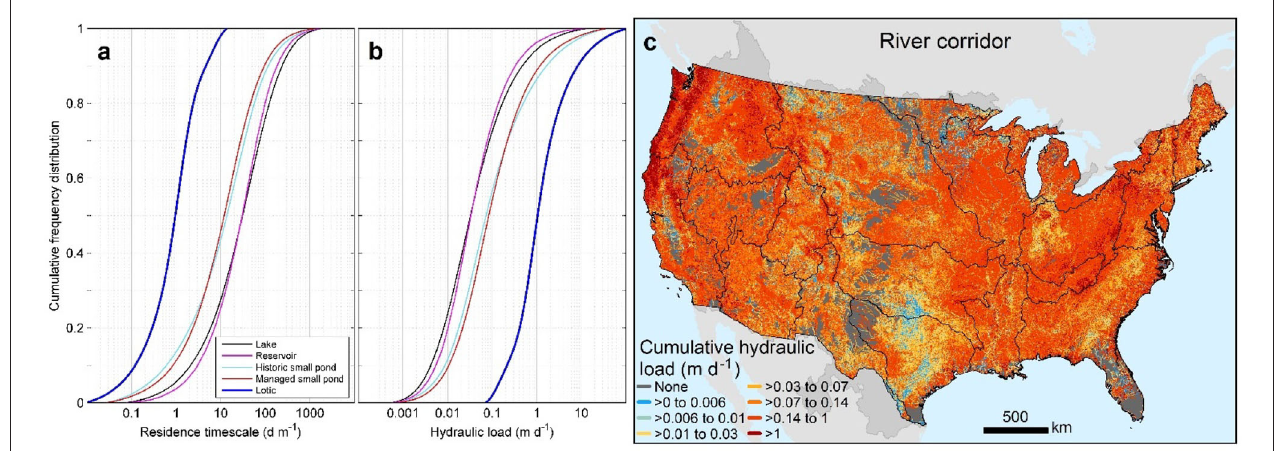
FIGURE 4 | Frequency distributions of residence timescale (a) and hydraulic load (b) of individual waterbodies and cumulative hydraulic load across the CONUS (c) . The cumulative hydraulic load is the inverse of the cumulative area-weighted residence timescale across the CONUS shown in Figure 5d . Black boundaries designate HUC-2 river basins.